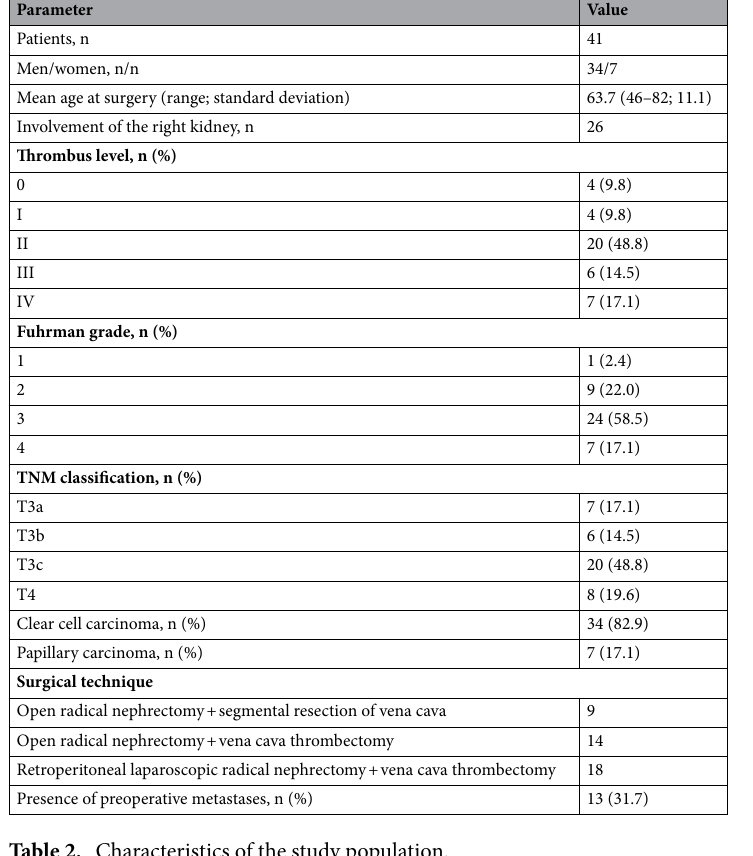
Table 2. Characteristics of the study